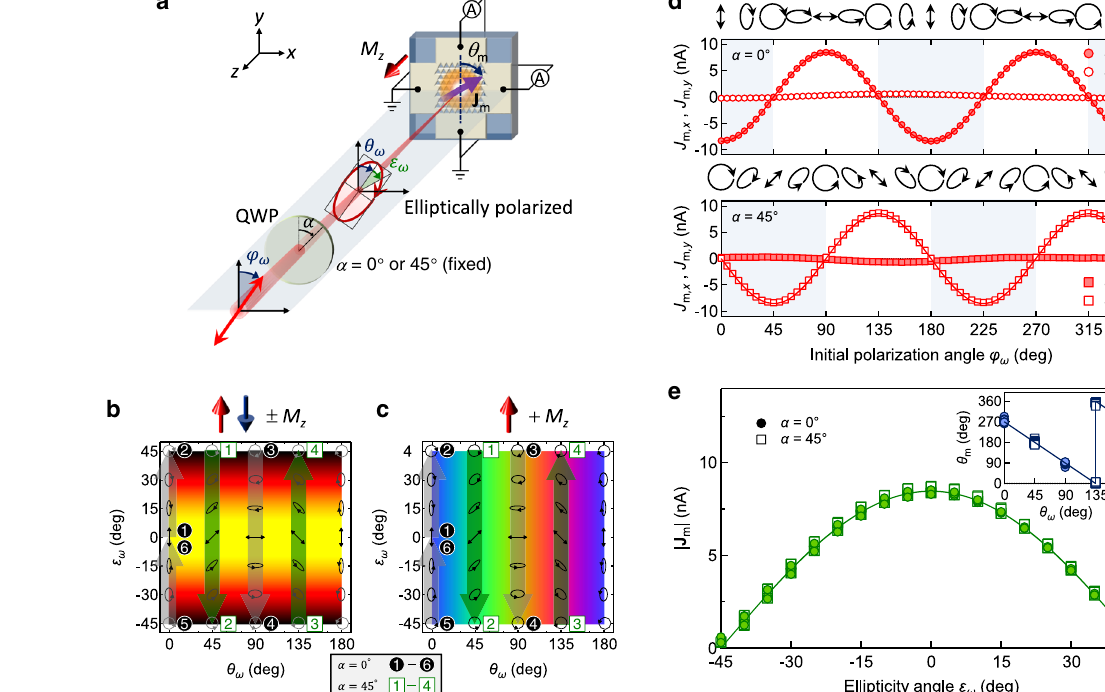
Fig. 4 | Simultaneous control of the magnitude and direction of spin-driven photocurrents. a Schematic showing the experimental setup for measuring zero- biasphotocurrentsalongthe x and y directionsatnormalincidenceofcontinuously polarization-modulated 800-nm light. The polarizationstateof the excitation light isdeterminedbytheinitialpolarizationangle φ ω androtationangle α oftheoptical axisof the quarter-wave plate (QWP). b , c 2Dcolor mapsof( b ) ∣ J m ∣ for± M z and ( c ) φ ω crossestheverticaldirections(markedbythickarrows). ε ω can θ m for+ M z when